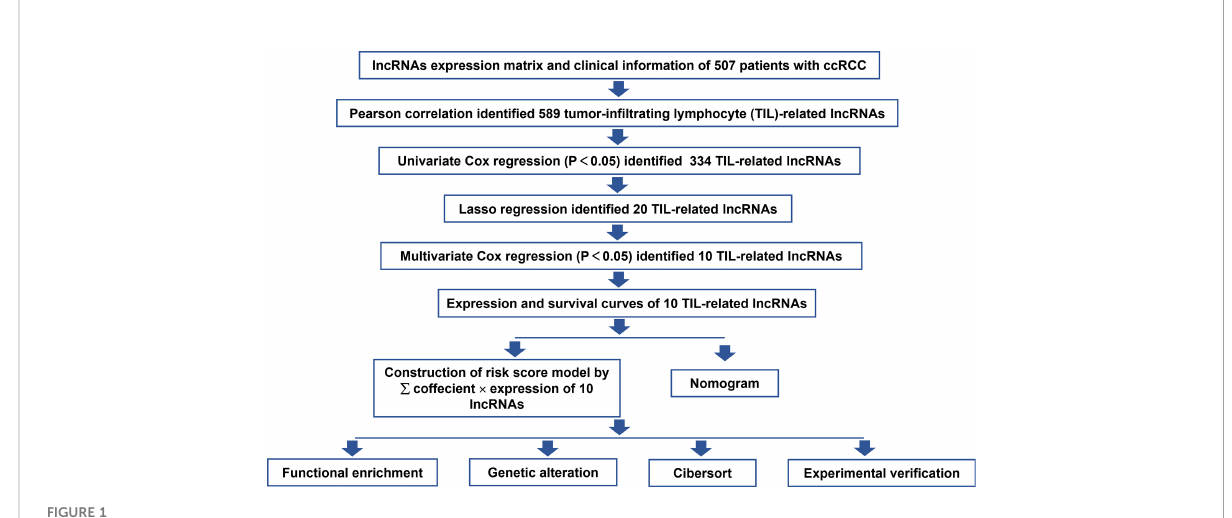
FIGURE 1 Flowchart of the study strategy.